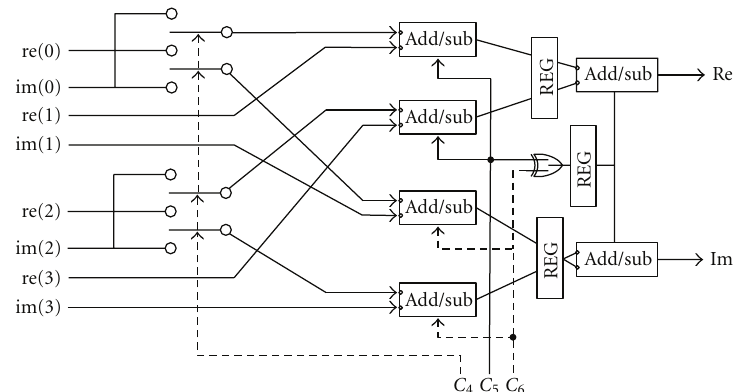
Figure 8: Adding pipeline registers to R4SDC butterfly element.